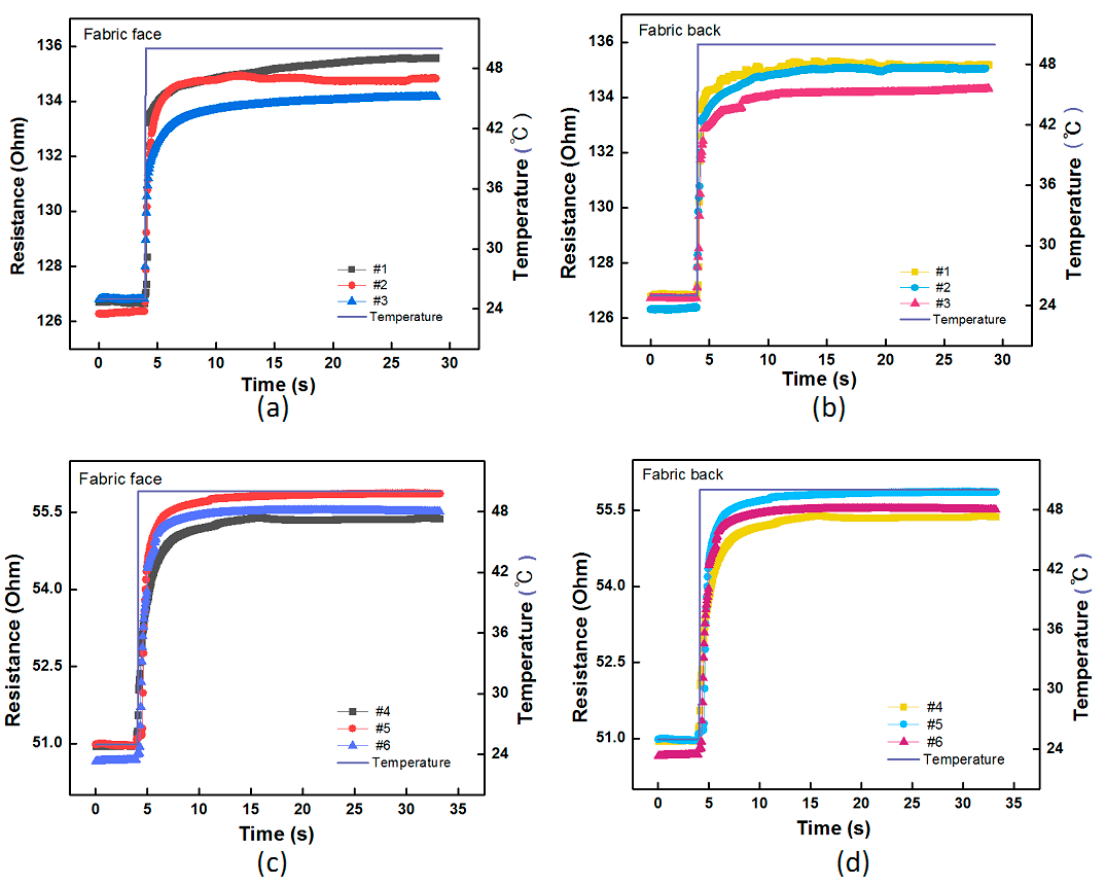
Figure 11. Response time of all the fabric temperature sensors in oil bath. ( a , b ) Resistance/temperature-time curves of the sensors with front and back sides from No.1 to 3; ( c , d ). Resistance/temperature-time curves of the sensors with front and back sides from No.4 to 6. Table 5. Response time of the fabric temperature sensors in oil bath with two sides.